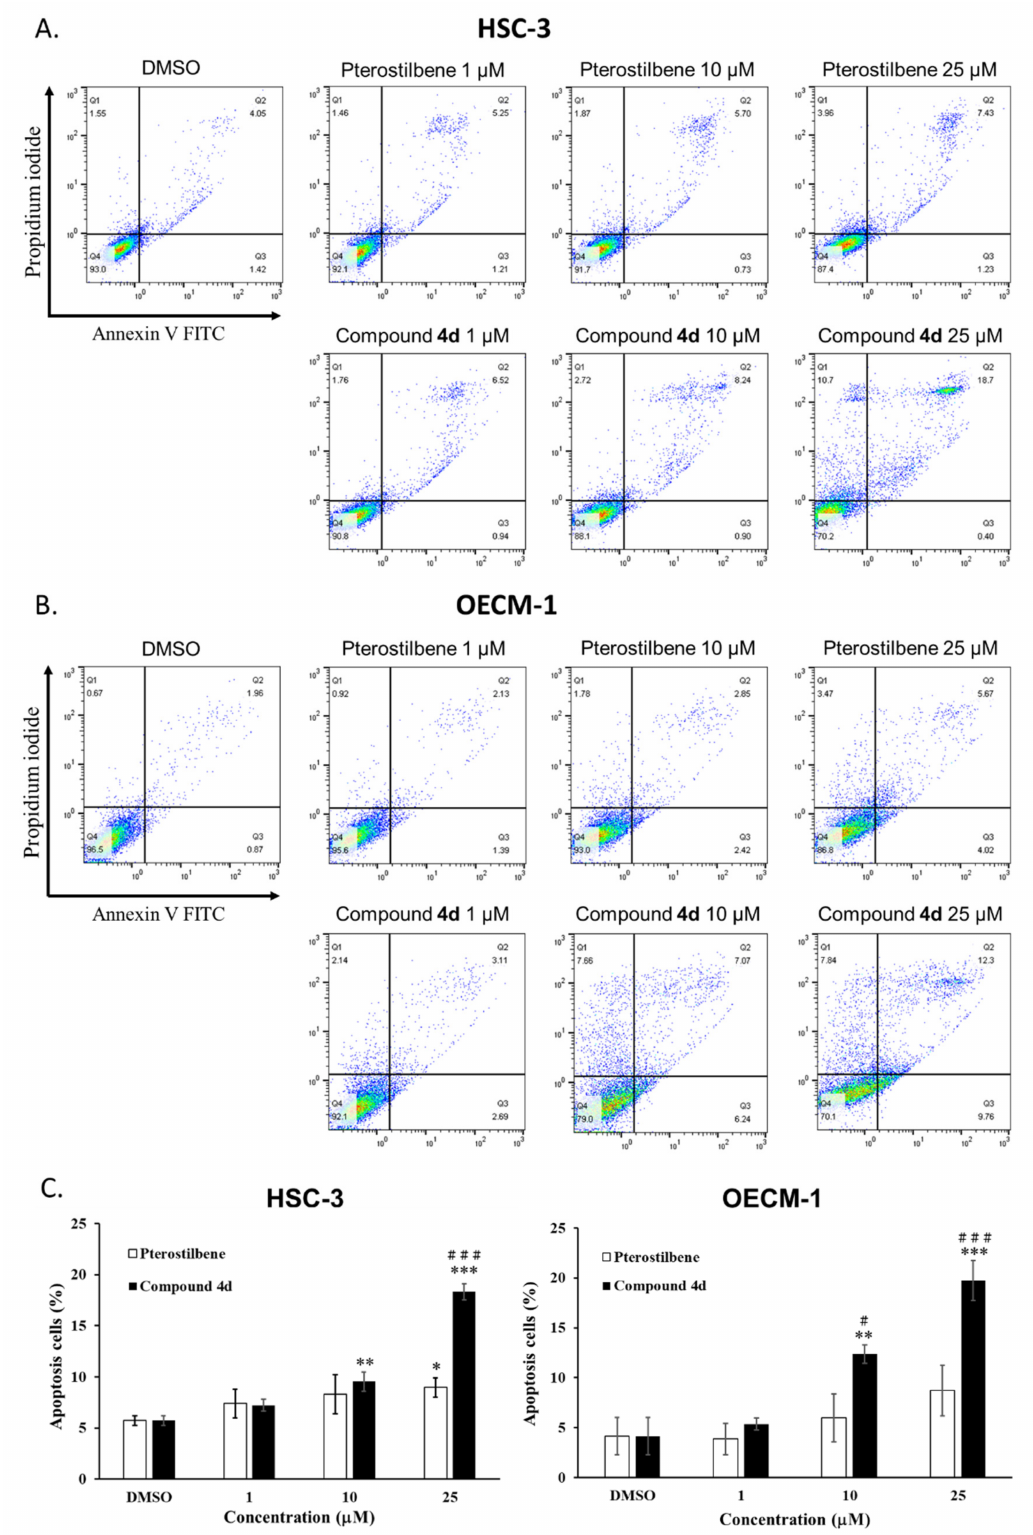
Figure 7. The effect of cell apoptosis induced by compound 4d . ( A ) HSC-3 and ( B ) OECM-1 cells treated by compound 4d or Pterostilbene for 24 h were subjected to annexin V and PI staining and flow cytometric analysis. ( C ) The quantitative analysis of ( A , B ). Statistically significant differences are indicated as follows: * p < 0.05, ** p < 0.01, *** p < 0.001 between each group and vehicle control; # p < 0.05, ### p < 0.001 between compound 4d treatment and the same concentration of pterostilbene